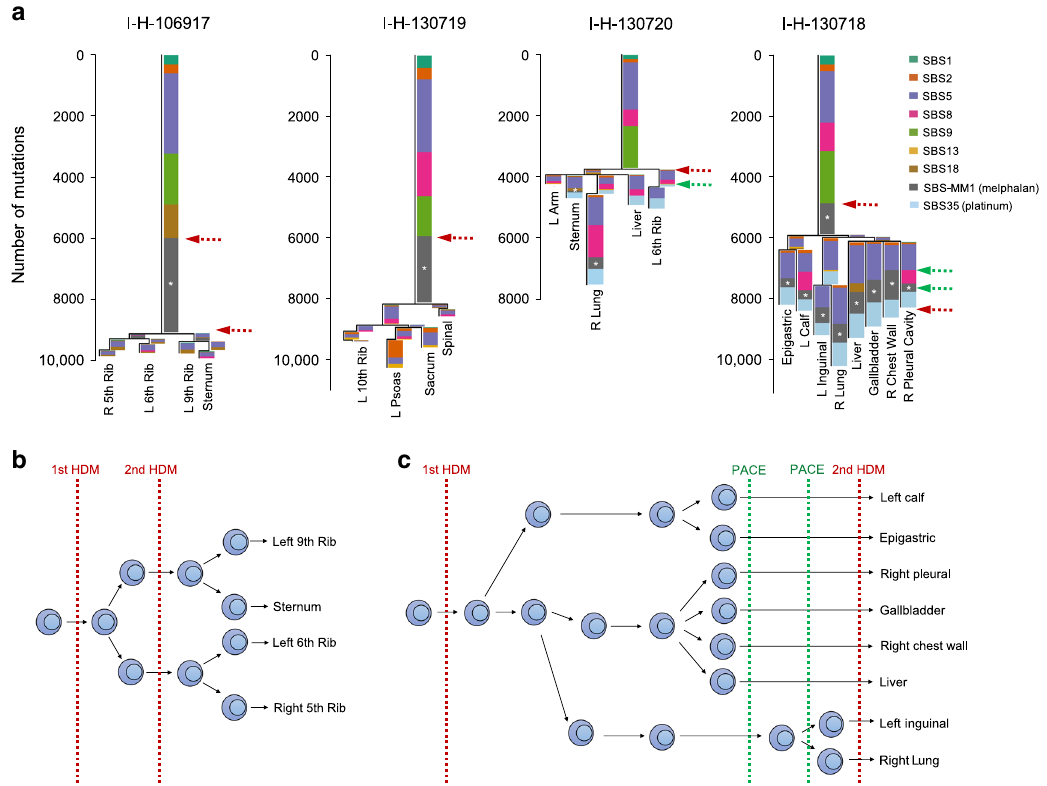
Fig. 6 Timeline of mutational signatures. a Mutational signature contribution for each phylogenetic tree cluster for each sample. Asterisks indicate the presence of transcriptional strand bias for SBS-MM1. Red and green dashed arrows represent exposure to melphalan and platinum-based therapies, respectively. L = left; R = right. B-cc) A schema summarizing the relationship between chemotherapy, subclonal selection and seeding in ( b ) I-H-106917 and ( c ) I-H-130718. (HDM = high-dose melphalan, PACE = cisplatin, doxorubicin, cyclophosphamide and etoposide, SBS = single base substitution). Red and green dashed lines in ( b ) and ( c ) represent exposure to melphalan and platinum-based therapies,